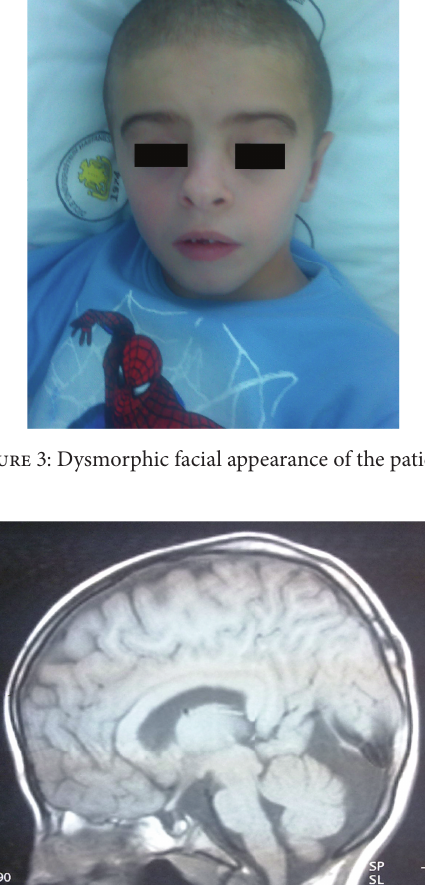
Figure 2: The presence of low-set and cup shaped ears.